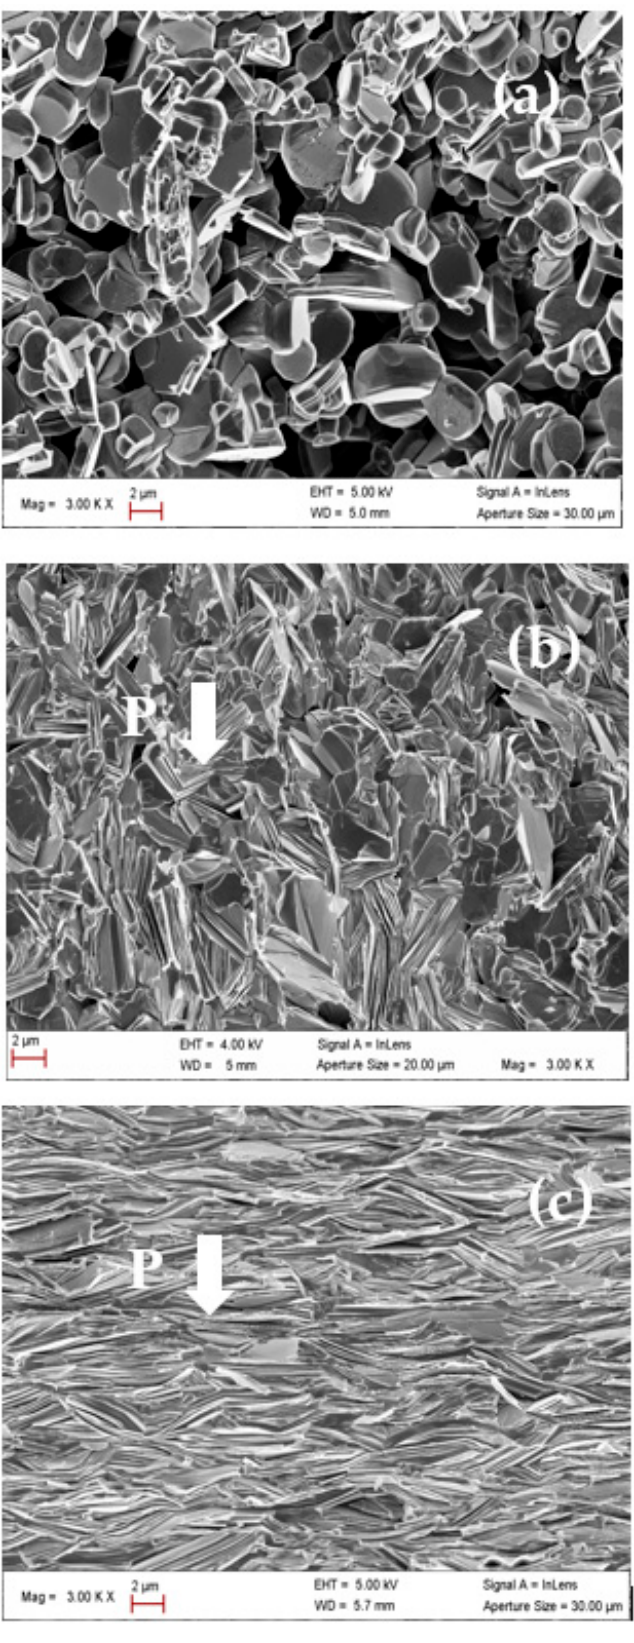
Figure 4. SEM micrographs of the Ca 3 Co 4 O 9 p -type thermoelectric ( a ) Conventional Sintered (CS). ( b ) Spark Plasma Sintering sample, fractured surfaces parallel to applied pressure (P) and ( c ) Spark Plasma Texturing (SPT) sample.